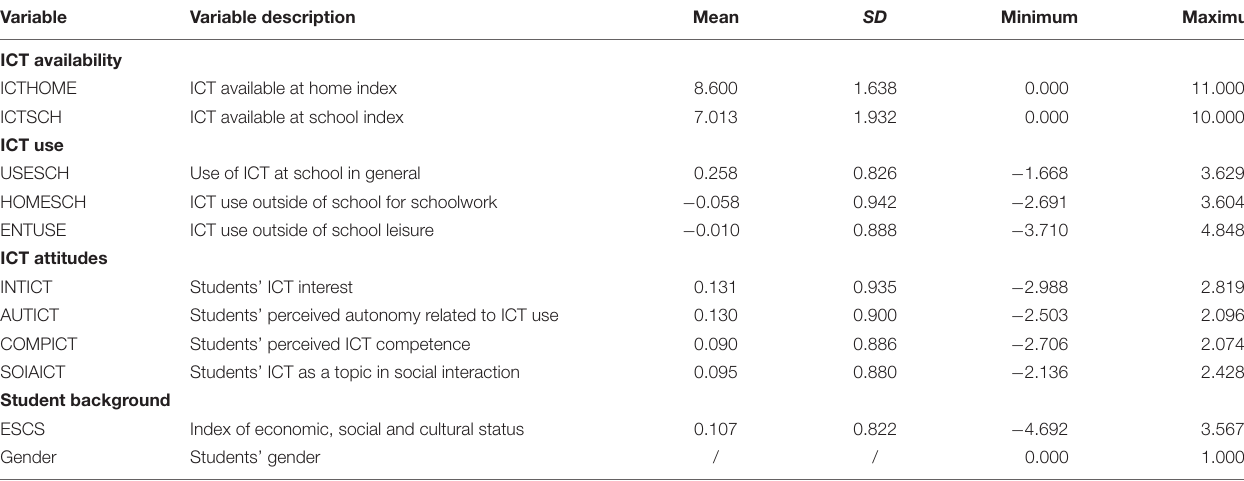
TABLE 3 | Descriptive statistics of ICT availability, ICT use, ICT attitudes and student background based on the PISA 2015 computer-based reading